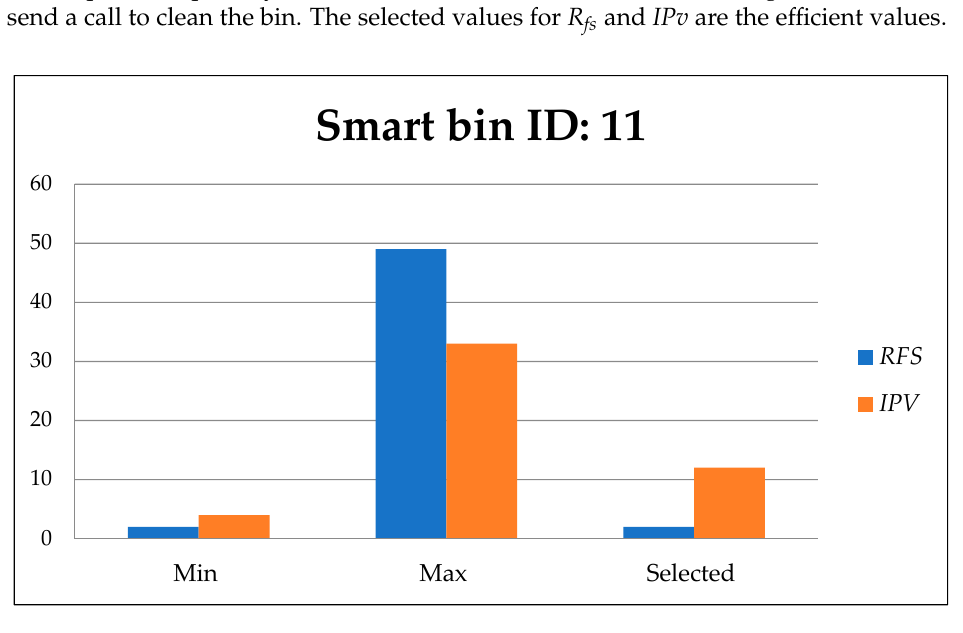
Figure 14. Residual free space R fs , and importance priority value IPv to smart bin id: 11.